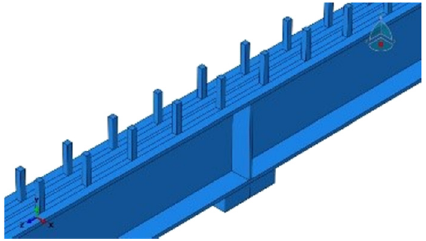
Figure 3: Shear connectors distribution for Group